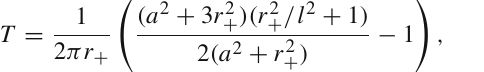
Fig. 12 Free energy of a Kerr black hole in the Rényi model against the temperature for various angular momenta J 0 , λ J 0 = 0 . 01 (green), λ J = 0 . 02 (red) and λ J = 0 . 1 (blue). Characteristic swallowtail 0 0 behavior is observed for λ J 0 = 0 . 01 (green), which corresponds to a